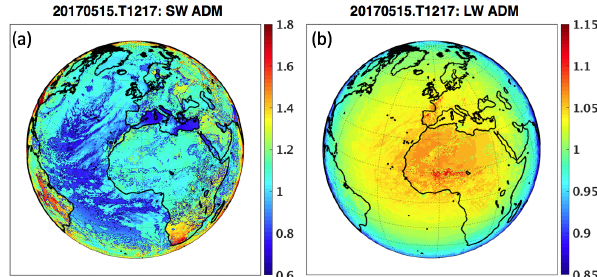
Figure 4. SW anisotropic factors (a) and LW anisotropic factors (b) derived from the CERES ADMs using the EPIC composite for scene identification for 15 May 2017 at